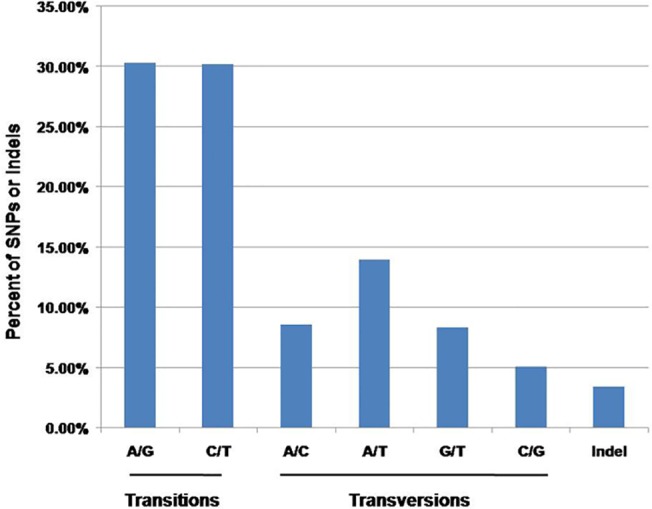
Classification of single nucleotide polymorphisms (SNPs) identified from the C.hongkongensis transcriptome.Transitions occurred more frequently than transversions. The overall frequency of all types of SNPs including indels was one per 392 bp.